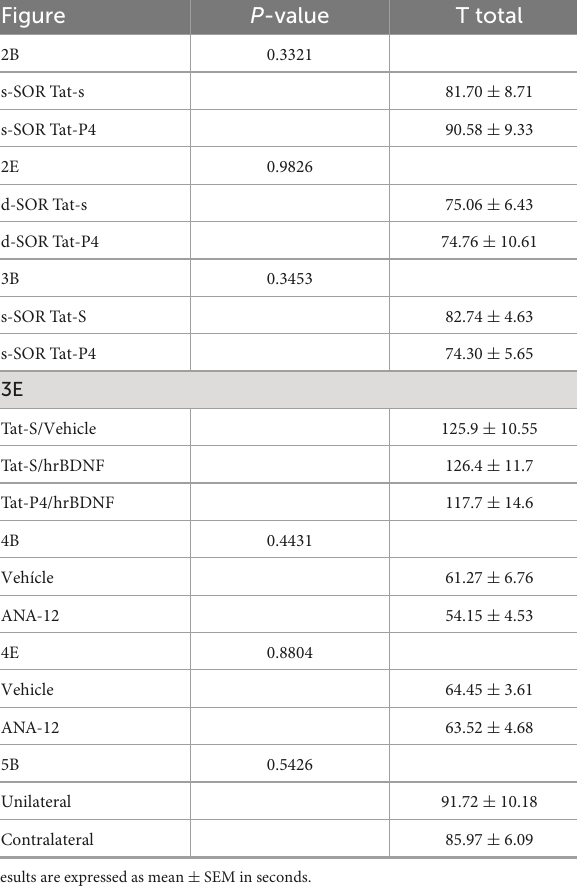
TABLE 2 Total exploration times during the sample session of the spontaneous object recognition (SOR) task. Figure P